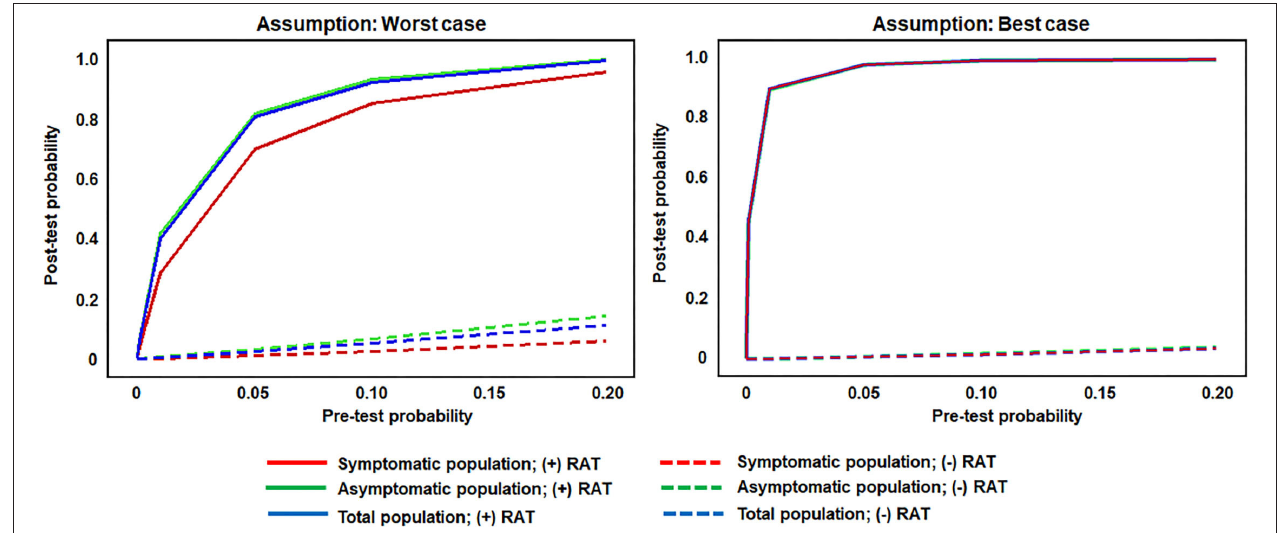
FIGURE 3 | Post-test probability values for RAT-positive and -negative results across theoretical pre-test probabilities (prevalence values) and utilitzing set sensitivity and specificity values. RAT pre-test and post-test probability of infection in the symptomatic population (sensitivity of 77.2 and 85.6% in the worst antigen diagnostic performance estimates and best antigen diagnostic performance estimates, respectively; and specificity of 97.9 and 99.9% in the worst antigen diagnostic performance estimates and best antigen diagnostic performance estimates, respectively), the asymptomatic population (sensitivity of 38.5 and 84.2% in the worst antigen diagnostic performance estimates and best antigen diagnostic performance estimates, respectively; and specificity of 99.4 and 99.9% in the worst antigen diagnostic performance estimates and best antigen diagnostic performance estimates, respectively), and the total population (sensitivity of 53.8 and 85.1% in the worst antigen diagnostic performance estimates and best antigen diagnostic performance estimates, respectively; and specificity of 99.1 and 99.9% in the worst antigen diagnostic performance estimates and best antigen diagnostic performance estimates, respectively). RAT, rapid antigen